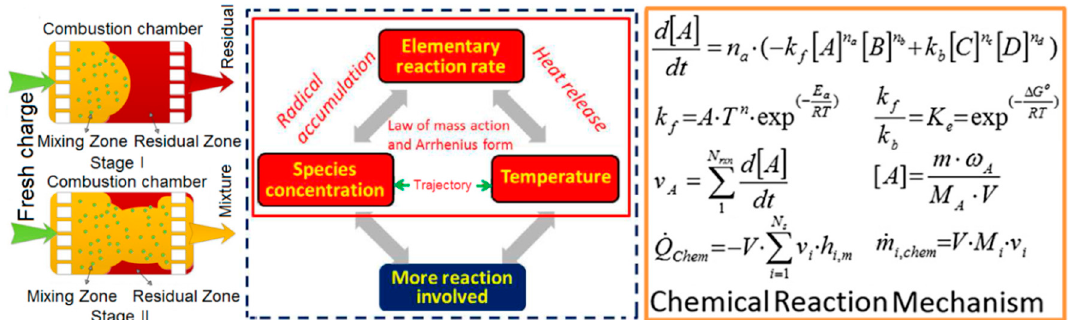
Figure 28. Study on cylinder flow fields and chemical dynamics from the University of Minnesota [32].